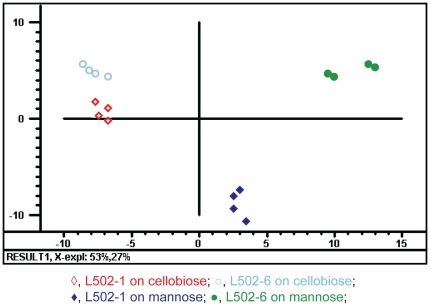
PCA score plot of the differentially regulated genes in the sakacin P-resistant strains.PCA score plot displaying global transcriptome profiles of L502-1 and L502-6 grown on mannose or on cellobiose compared to the wild-type strain grown on the same sugar. The two biological samples and their dye-swap replicates were included in the PCA. The explained variances for the two first components; PC1and PC2 are 53% and 27% respectively.